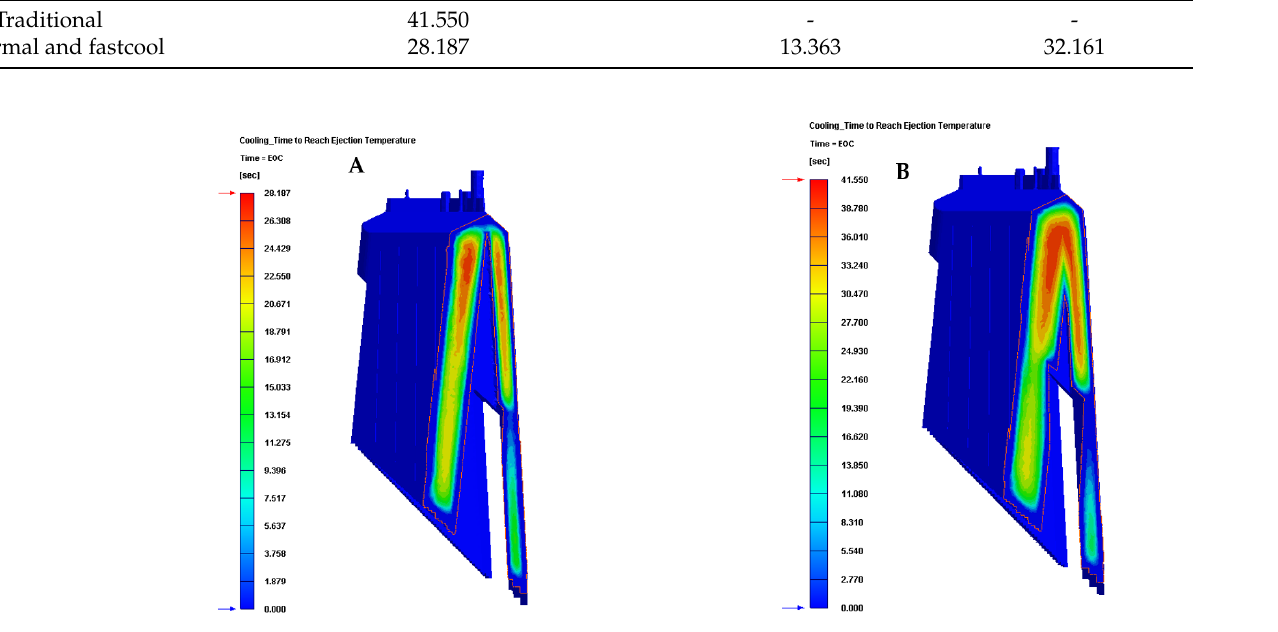
Figure 13. Time to reach ejection temperature (s). ( A ) Conformal cooling and fastcool insert. ( B ) Traditional cooling. Table 7. Time to reach ejection temperature for the analyzed cooling